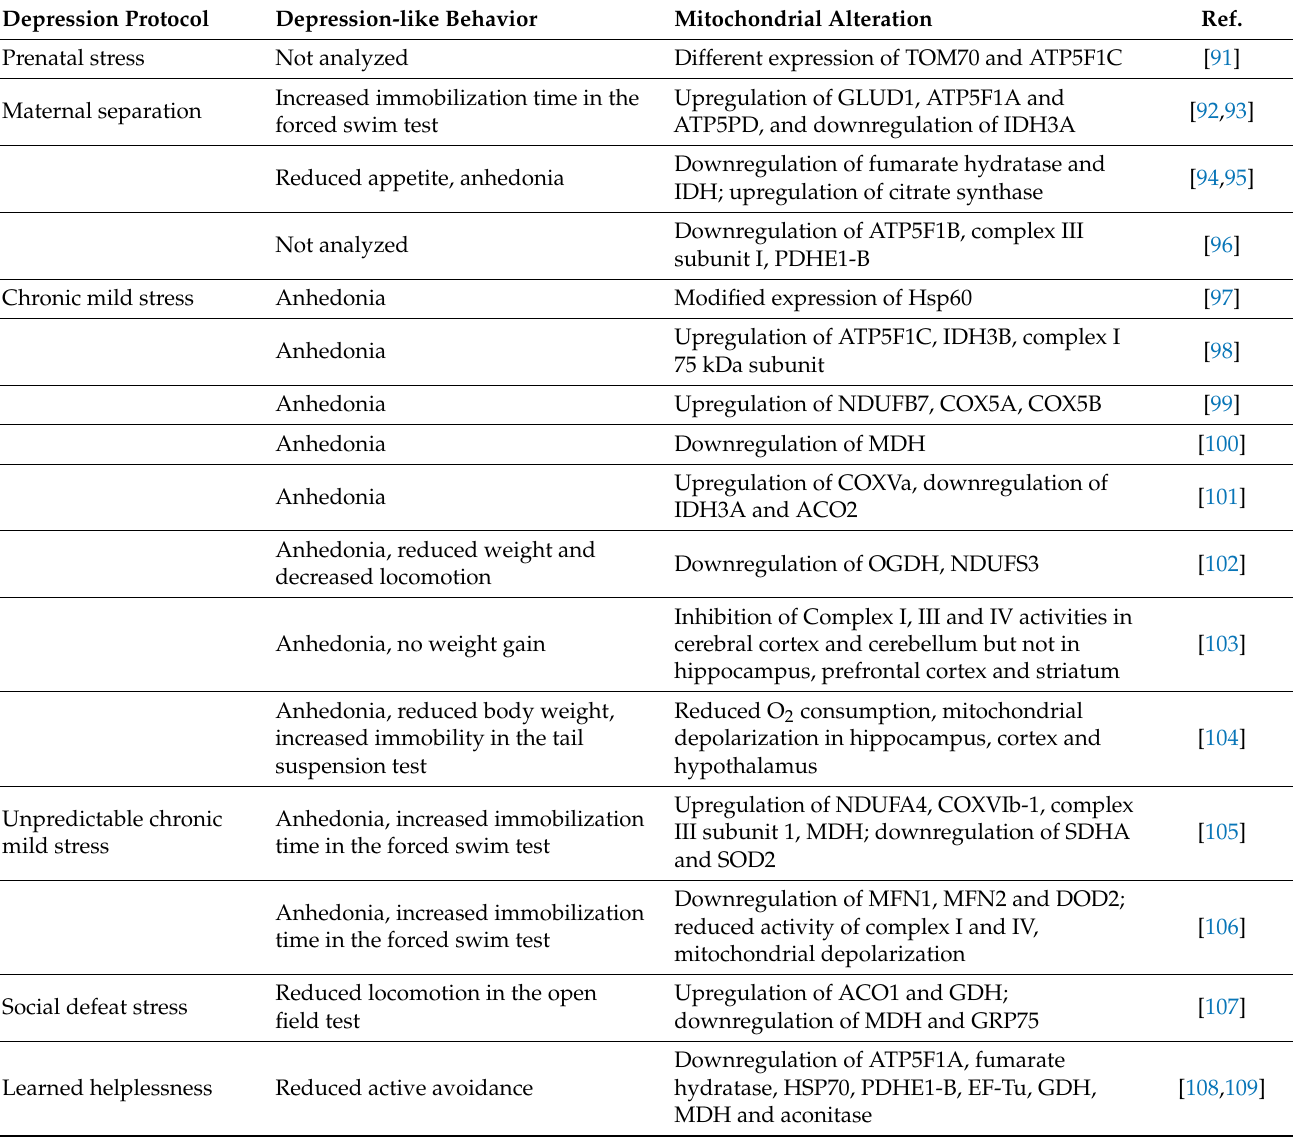
Table 1. Animal models of depression show various signs of mitochondrial